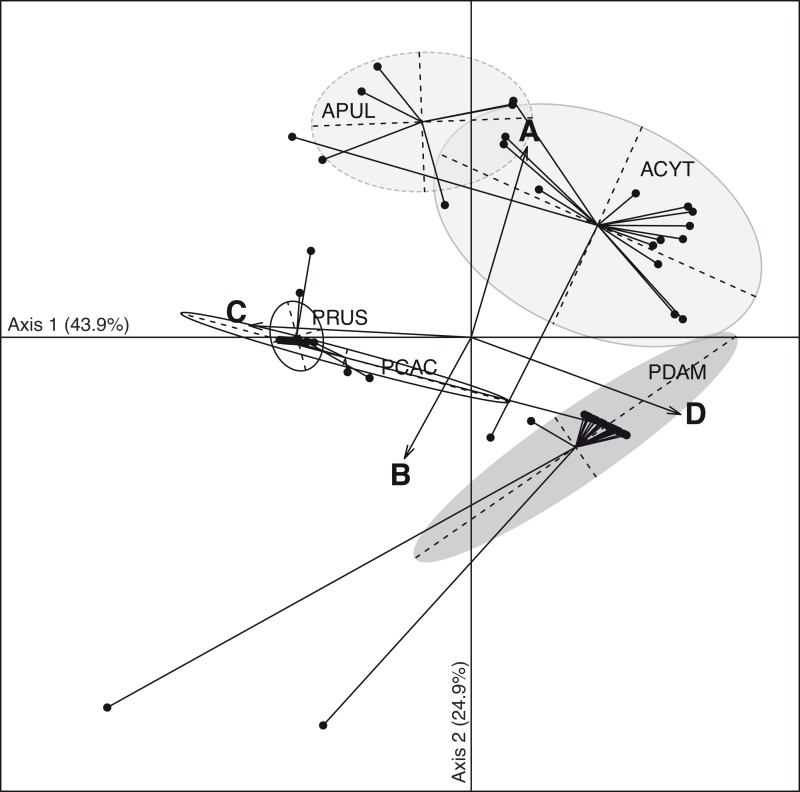
Spatio-temporal multivariate analysis of clade A–D quantifications converted in 28S copy number.Axis 1 and 2 of the discriminant analysis of principal component (DAPC) according to the five coral species: A. cytherea, A. pulchra, P. cactus, P. damicornis and P. rus.